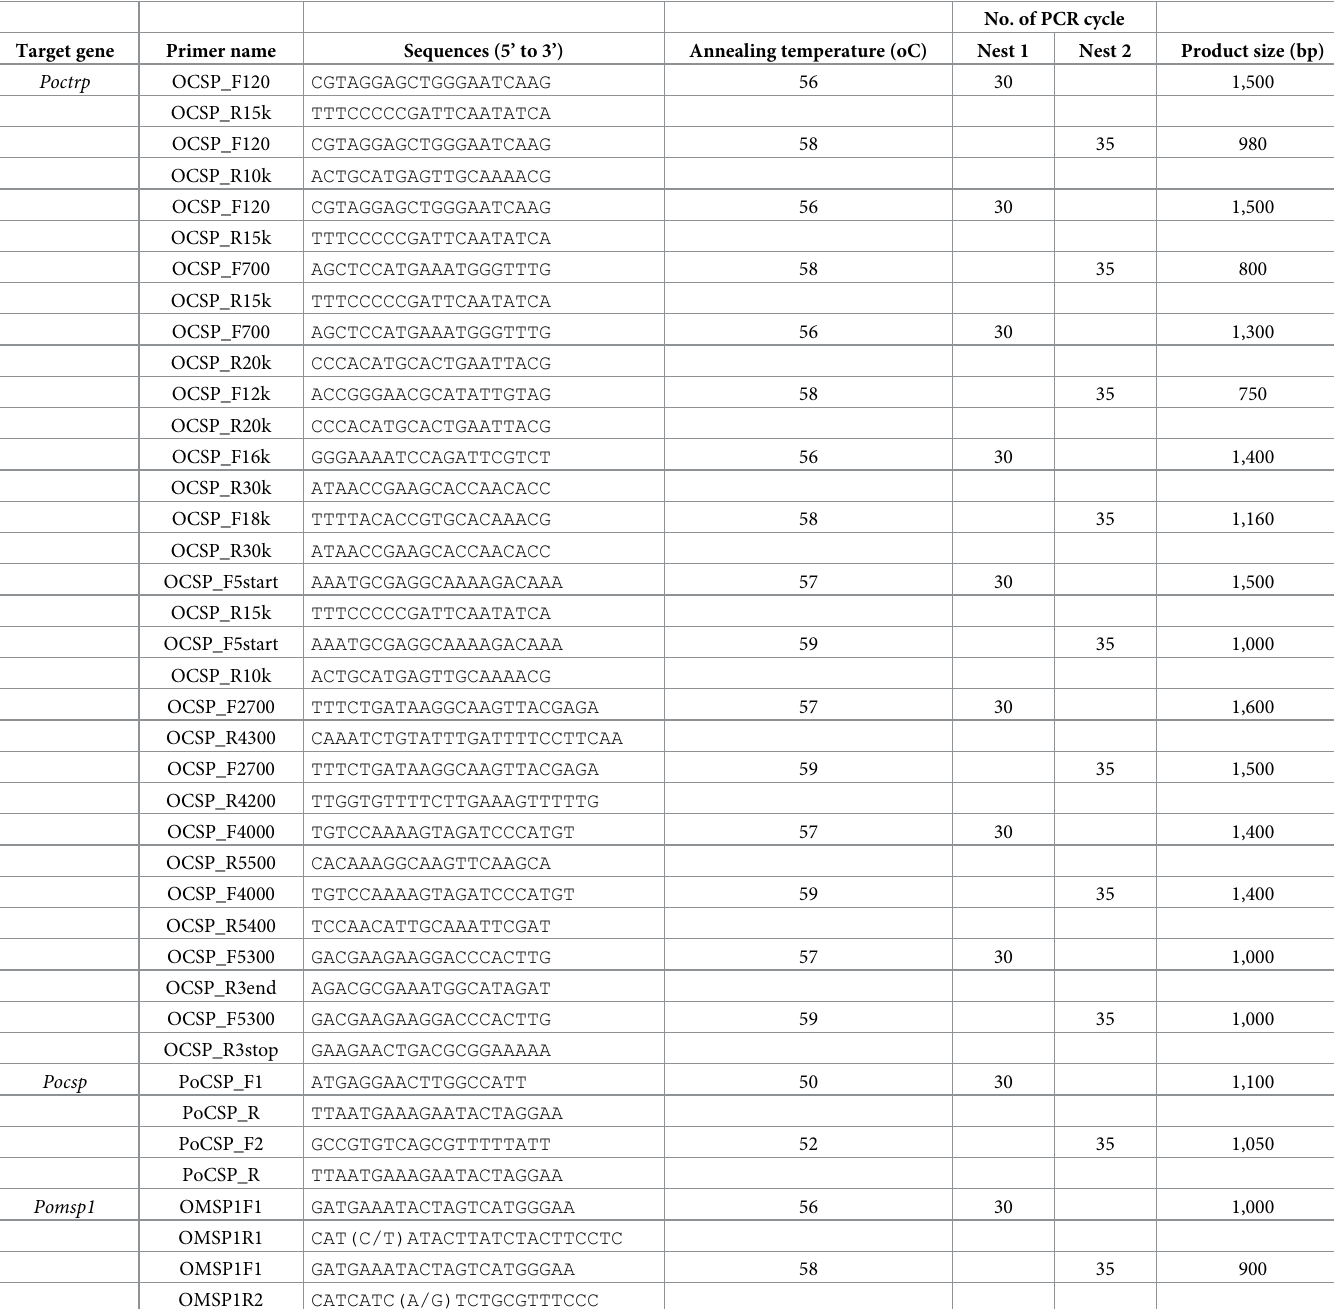
No. of PCR cycle